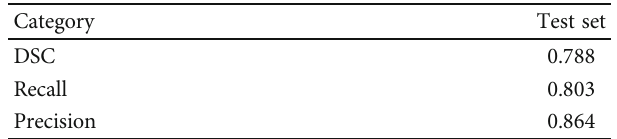
Table 1: Evaluation index result